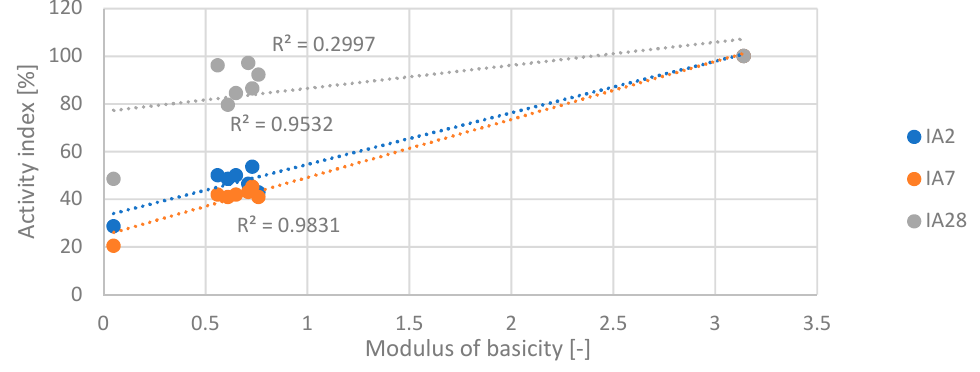
Figure 1. Dependence between modulus of basicity and activity indexes calculated in 2, 7, and 28 days.